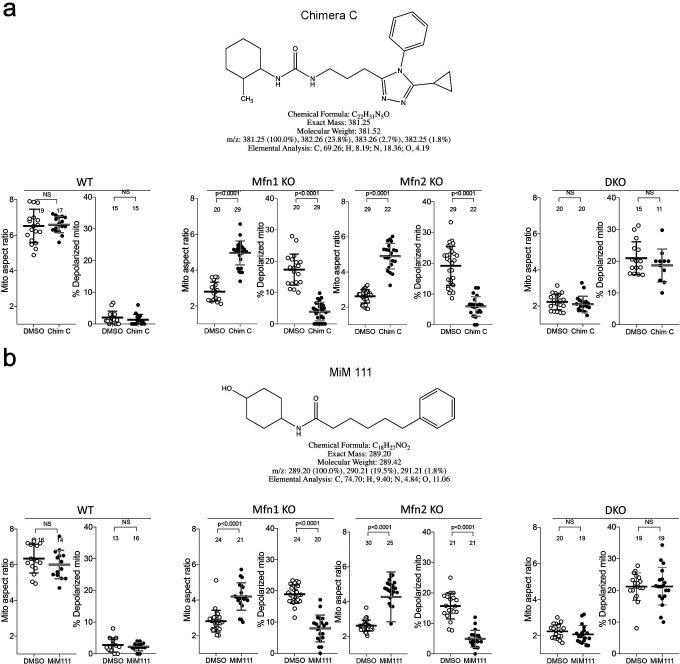
Chemical characteristics and functional profiling of mitofusin activators used in this study.(a) Chimera C is a member of the original chemical class of mitofusin agonists described in reference 23. (b) MiM111 is the prototype of new chemical class of mitofusin activators having pharmaceutical properties suitable for in vivo use, described in reference 25. Quantitative data below each structure show the effects of each compound (100 nM, 48 hr) on mitochondrial aspect ratio (length/width; a read-out for fusion) and depolarization (indicating respiratory dysfunction) in murine embryonic fibroblasts (MEFs) having different Mfn expression profiles: Wild-type MEFs (left) with both Mfn1 and Mfn2 have normal aspect ratios, low depolarization, and are not affected by mitofusin activation. Mfn1 and Mfn2 KO MEFs (middle) expressing only Mfn2 or Mfn1, respectively, have impaired fusion with low aspect ratios, high depolarization, and both of these abnormalities improve with either mitofusin activator. Mfn double knockout MEFs (DKO, right) have no mitofusin targets, so mitochondrial fragmentation and depolarization do not respond to mitofusin activation. P values by t-test.